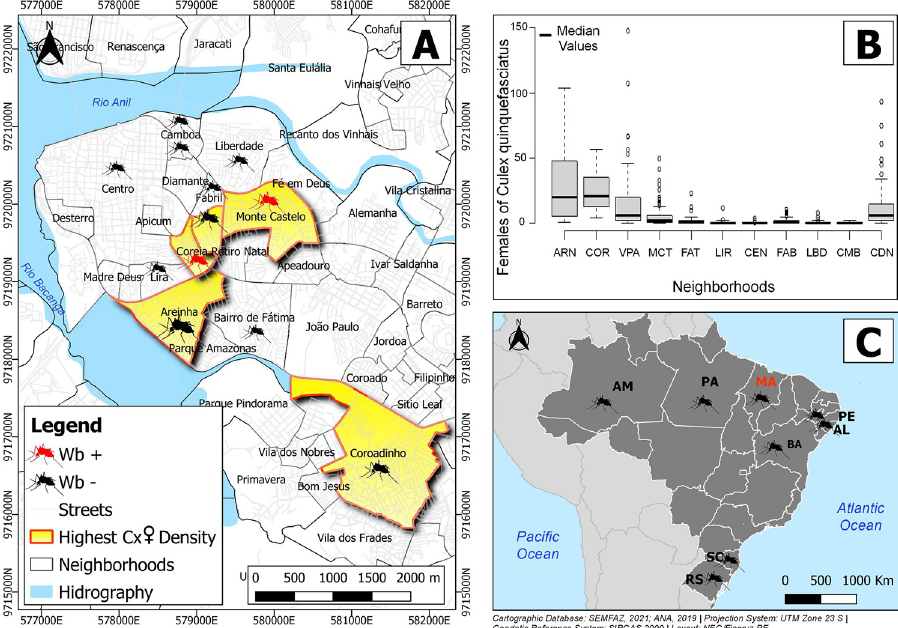
Fig 1. Entomological survey areas ranked with regard to the number of engorged or gravid C . quinquefasciatus females collected. (A) Map with the neighborhoods of S ã o Luı´s: ARN—Areinha; COR—Core´ia; VPA—Vila Passos; MCT—Monte Castelo; FAT—Fa´tima; LIR—Lira; CEN—Centro; FAB—Fabril; LBD—Liberdade; CMB—Camboa; CDN—Coroadinho. In red: five neighborhoods with the highest number of engorged or gravid C . quinquefasciatus females. Red mosquitoes: pools positive for Wb ; Black mosquitoes: pools negative for Wb . (B ) Means and standard deviations of the numbers of C . quinquefasciatus females collected per home. (C) LF history represented in Brazil map with states and some cities: AL–Alagoas (Maceio´); AM–Amazonas (Manaus); BA–Bahia (Castro Alves); MA– Maranh ã o (S ã o Luı´s); PA–Para´ (Bele´m); PE–Pernambuco (Recife); RS–Rio Grande do Sul (Porto Alegre); SC–Santa Catarina (Ponta Grossa, Chapeco´). Mosquito design by Freepik from https://www.freepik.com/free-vector/mosquito- silhouette-pack-nine_3138780.htm. Neighborhoods data from INCID (https://saoluis.ma.gov.br/arquivodacidade/ pagina/3472) and hydrographic from ANA https://metadados.snirh.gov.br/files/7d054e5a-8cc9-403c-9f1a- 085fd933610c/geoft_bho_massa_dagua_v2019.zip. (50 ♀ ) and Monte Castelo (42 ♀ ). In all neighborhoods, the proportion of engorged or gravid C . quinquefasciatus females per premise was higher than 60%, with an overall average of 75%. In S ã o Luı´s, mosquitoes were collected using an aspirator (collection time, 15 minutes), and it was necessary calculate bites per human-hour/days and year. It was only possible to specu- late an indirect ABR (range: 2,879–210,327), the average number of engorged or gravid Culex females per premise, divided by the measure of residents per premise per neighborhood (IBGE source).